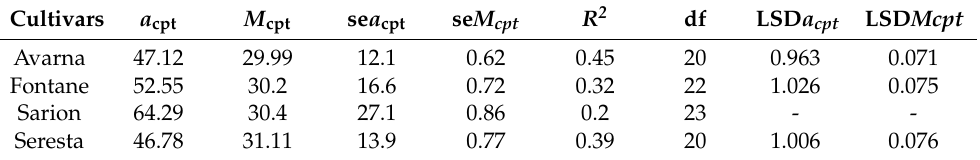
Table 3. The output parameter of the logistic model by using Equation 6 of four potato culti- vars: Avarna, Fontane, Sarion, and Seresta, where a cpt = maximum rate of canopy temperature increase; M cpt = maximum canopy temperature reached ( ◦ C); se a cpt = standard error of maximum rate of canopy temperature; se M cpt = standard error of maximum canopy temperature reached ( ◦ C); R 2 = coefficient of determination; df = degrees of freedom. Parameter values are not significantly different compared to cv. Sarion at 5% level of significance. LSD = least significant